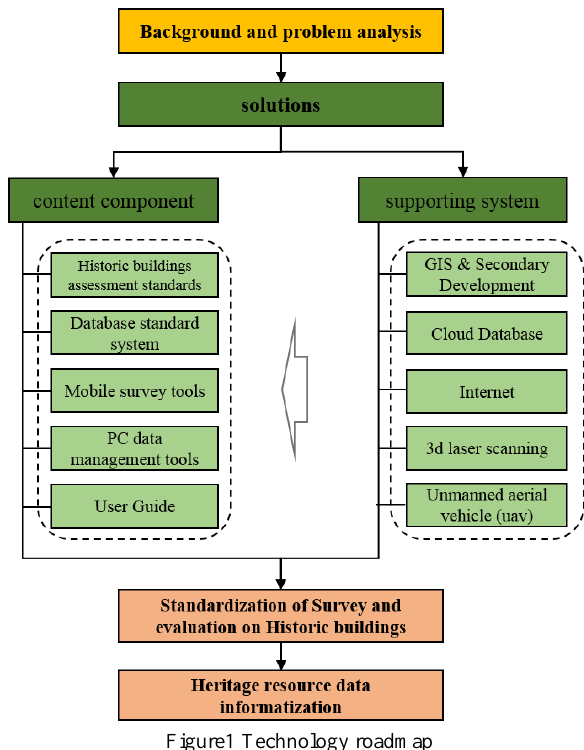
Figure1 Technology